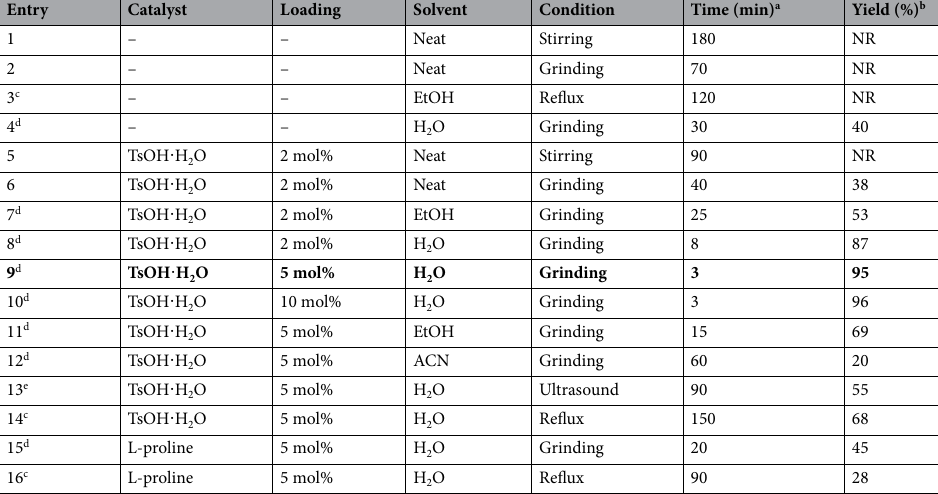
Table 4. Optimization of reaction conditions for the synthesis of 2,2 ′ -aryl/heteroaryl-methylene- bis(3-hydroxy-cyclohex-2-enone) derivatives. Reaction condition: Benzaldehyde 1a (1.0 mmol), 5,5-dimethylcyclohexane-1,3-dione 3a (2.0 mmol) in the presence or absence of catalyst(s) in different